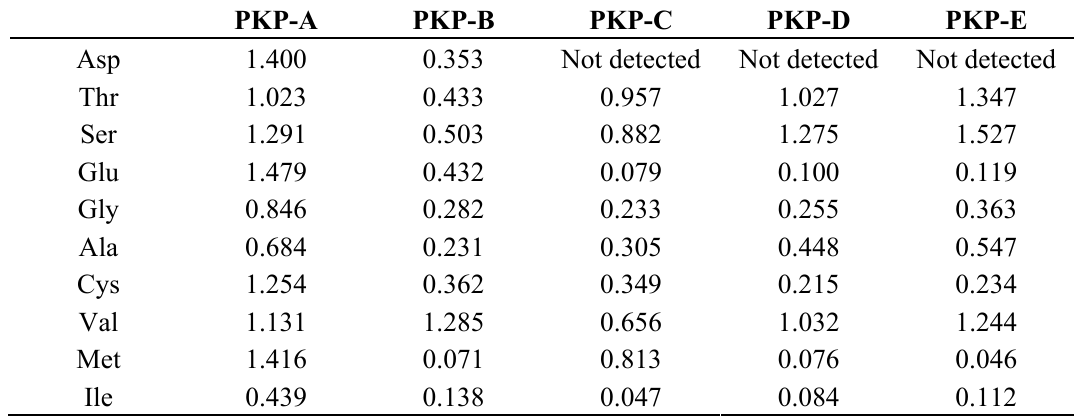
Table 2. Content of amino acid of five purified PKPs ( μ g·mg − 1